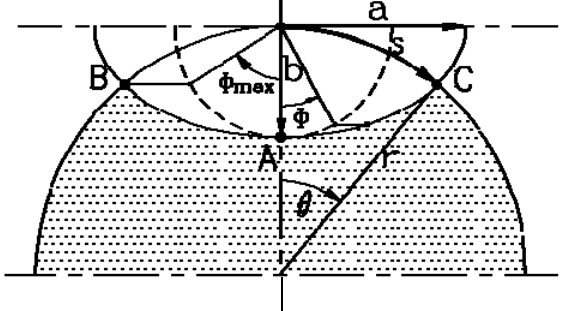
Figure 4: Geometry parameters of semi-elliptical surface crack.